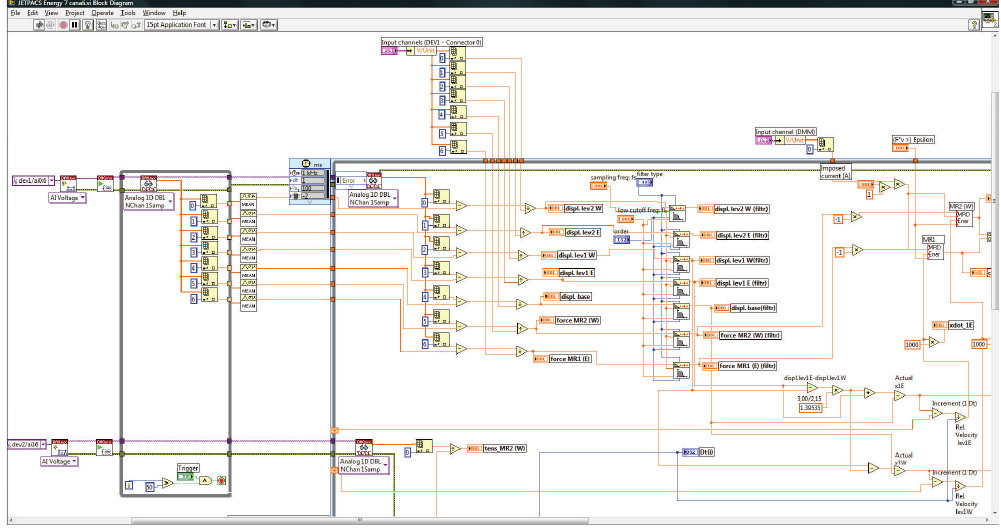
Figure 3: One of the programs written for the case study experience: a labview video